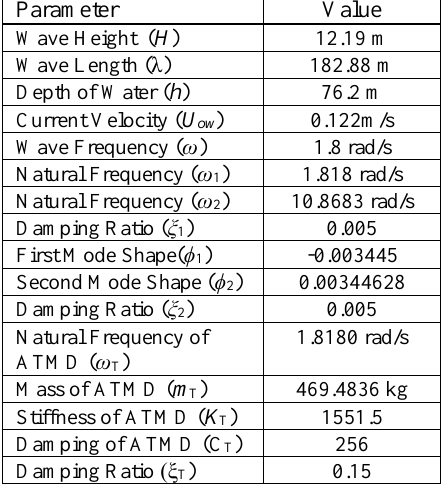
Table 1. Parameter values of considered offshore steel jacket